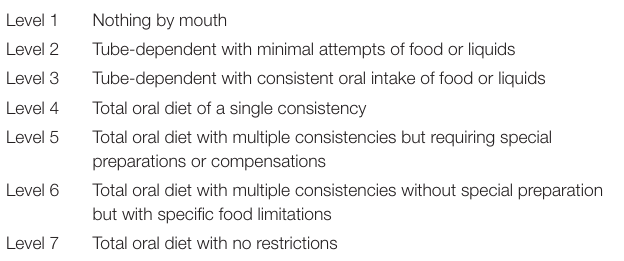
TABLE 1 | The functional oral intake scale according to Crary et al. (7). TABLE 2 | The modified functional oral intake scale for infants according Coppens et al.